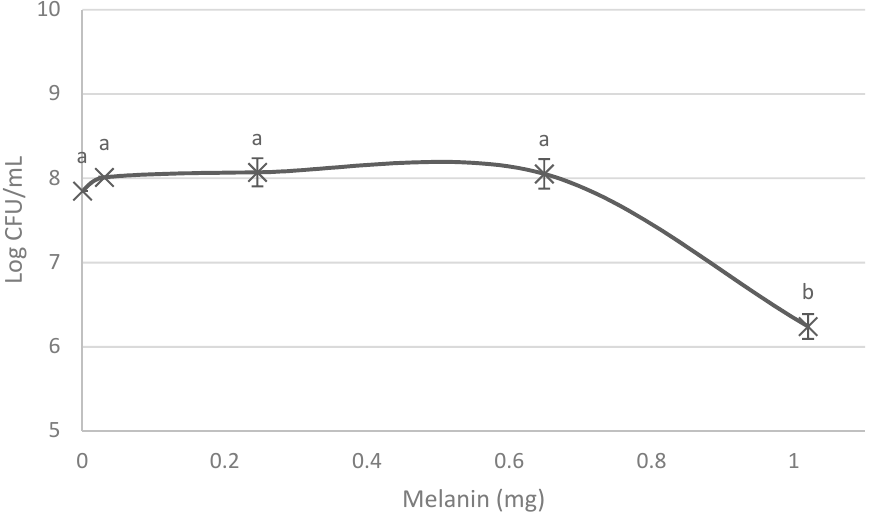
Figure 2. Effect of melanin production by Pseudomonas putida ESACB 191 in its growth and viability. The error bars values were calculated based on three replicates for each condition. (a, b) Different results at 95% confidence level.